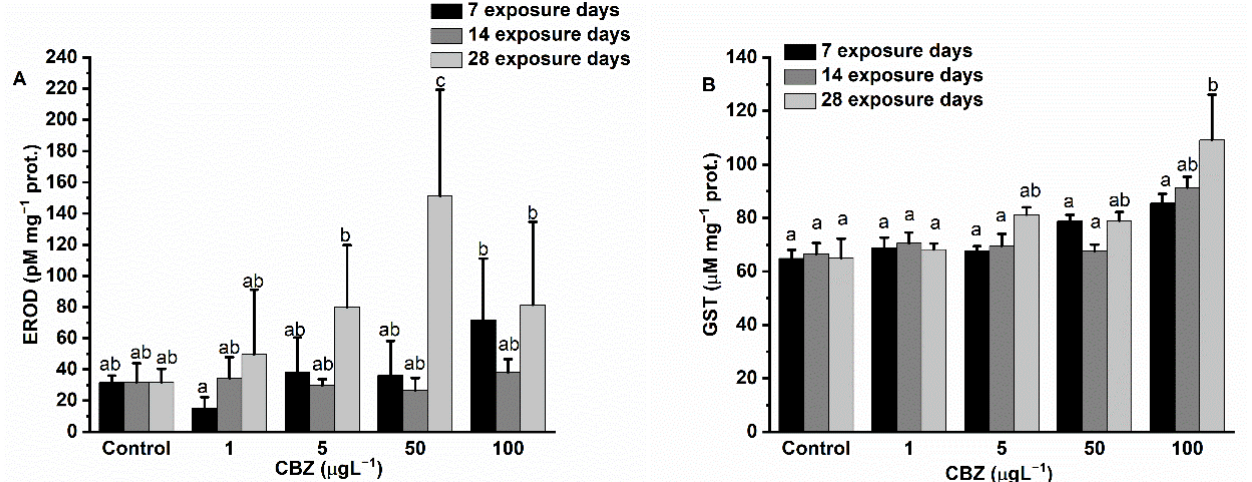
Figure 2. Effect of CBZ on level of hepatic EROD ( A ), and hepatic GST ( B ) in liver of common carp. Data are means ± S.D., n = 3. Columns sharing the same superscript letter indicate no significant differences after a two-way ANOVA followed by Tukey’s post-hoc test ( p > 0.05).